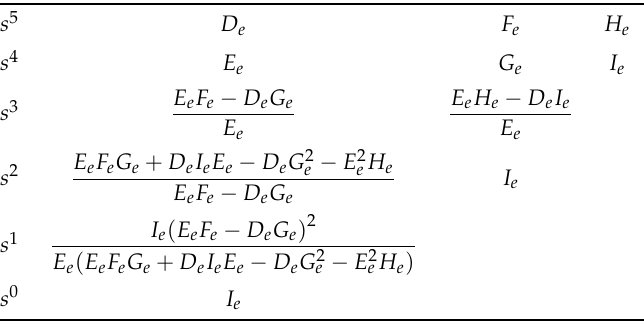
Table 2. Routh array of characteristic Equation of (16).